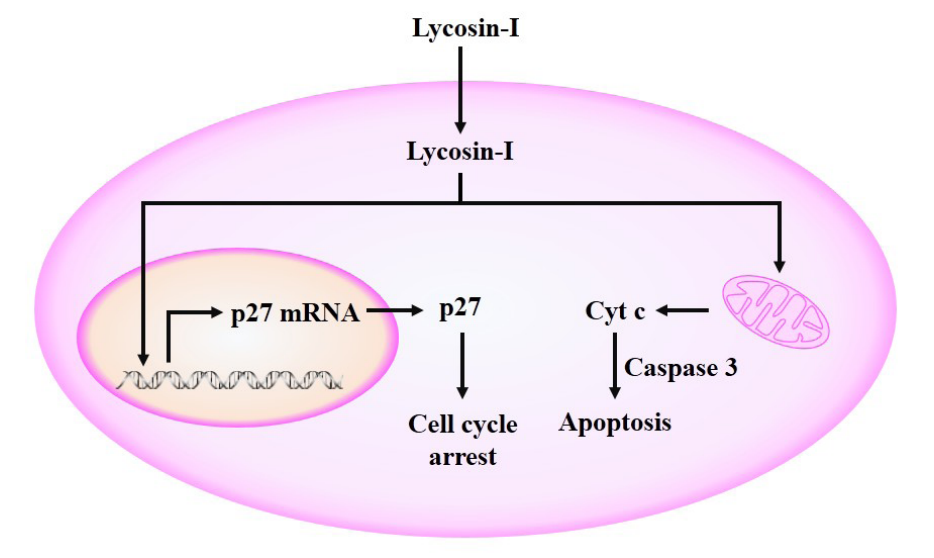
Figure 4. The anti-tumor mechanism of Lycosin-I . Lycosin-I penetrates into cytoplasm and upregulates p27 mRNA and protein expression to inhibit the cell cycle. Lycosin-I can bind with mitochondria membrane and promote a mitochondria-mediated death pathway to induce tumor cell apoptosis. Cyt c: cytochrome